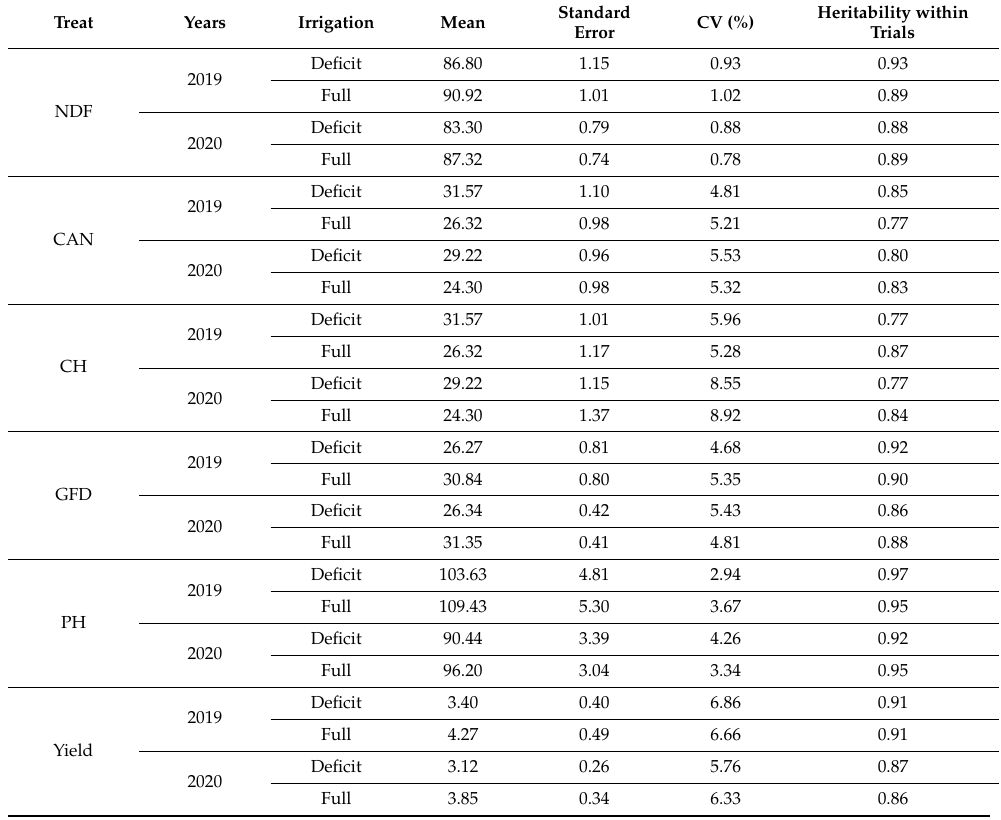
Table 1. The mean performance, coefficient of variance (CV, %) and heritability for the Number of Days to Flowering (NDF), Canopy Temperature (CAN), Chlorophyll Content (CH), Grain-Filling Duration (GFD), Plant Height (PH), and Grain Yield (Yield) for 2019 and 2020 growing seasons under Full Irrigation (FI) and Deficit Irrigation